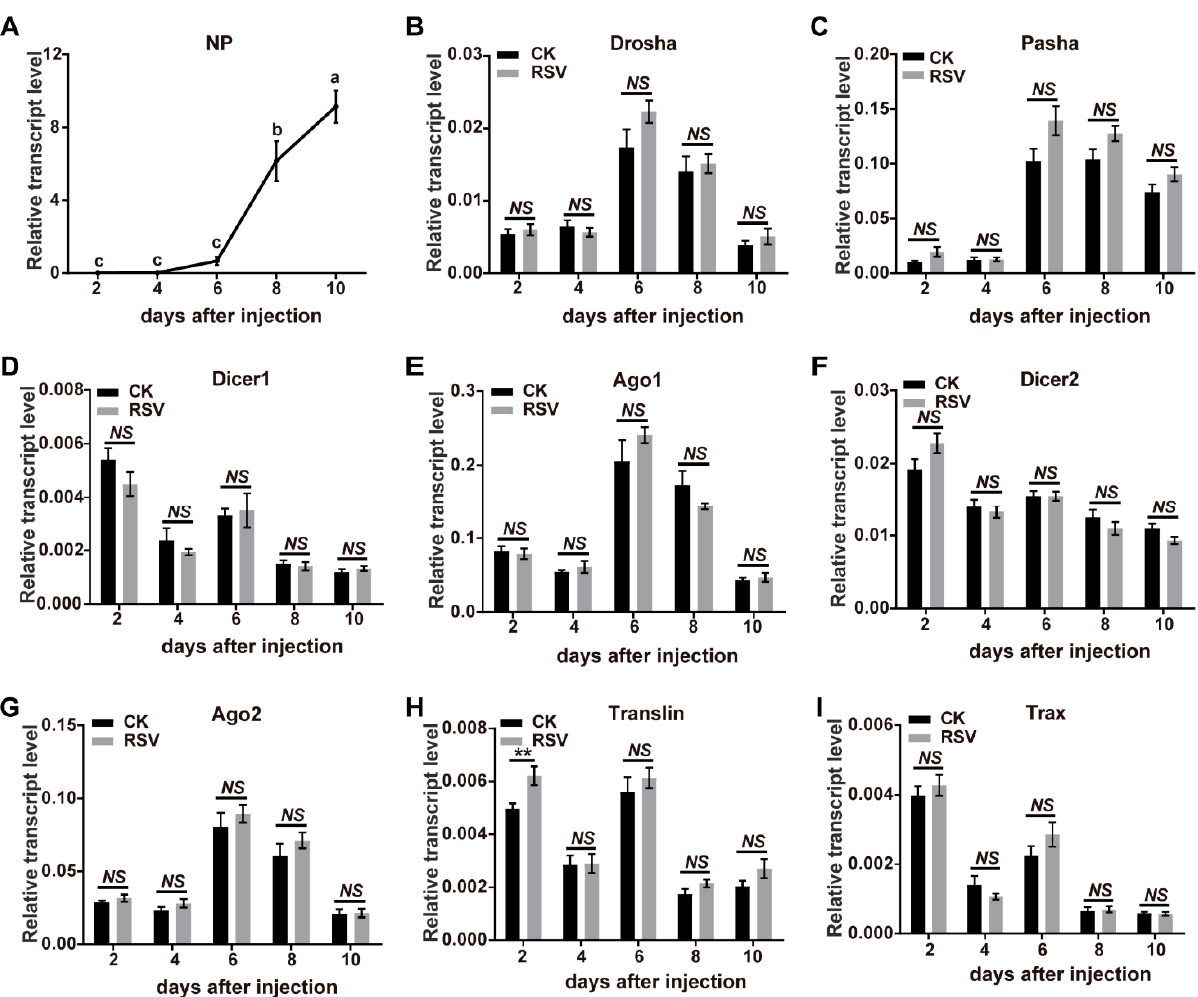
Figure 1. Response of miRNA and siRNA pathways to RSV infection in planthoppers. ( A ) The relative RNA levels of RSV NP in the planthoppers after injection of RSV crude preparations from viruliferous planthoppers measured with quantitative real ‐ time PCR (qPCR). Significant differences are indicated by different lowercase letters. ( B – I ) The relative transcript levels of Drosha , Pasha , Dicer1 , Ago1 , Dicer2 , Ago2 , Translin, and Trax in the miRNA and siRNA pathways during the infection process of RSV in the planthoppers were measured with qPCR. The crude preparations from nonviruliferous planthoppers were injected into the control groups (CK). The RNA or transcript levels of these genes were normalized to that of EF2 . The values represent the means ± SEs. NS, no significant difference. **, p < 0.01.